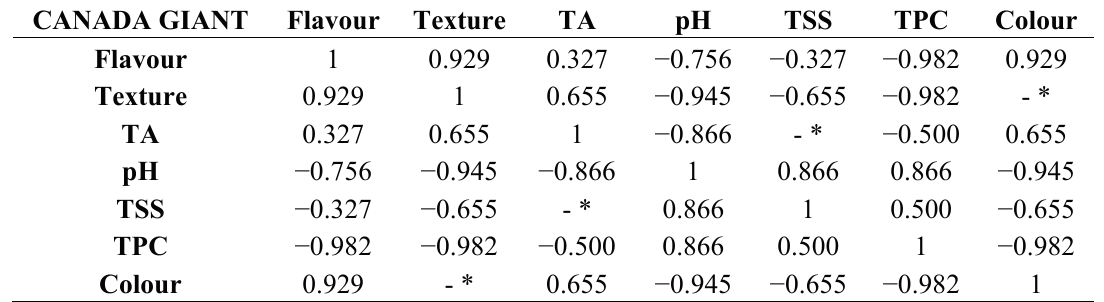
Table 8. Correlation between physicochemical and sensory attributes in the Canada giant cultivar. CANADA